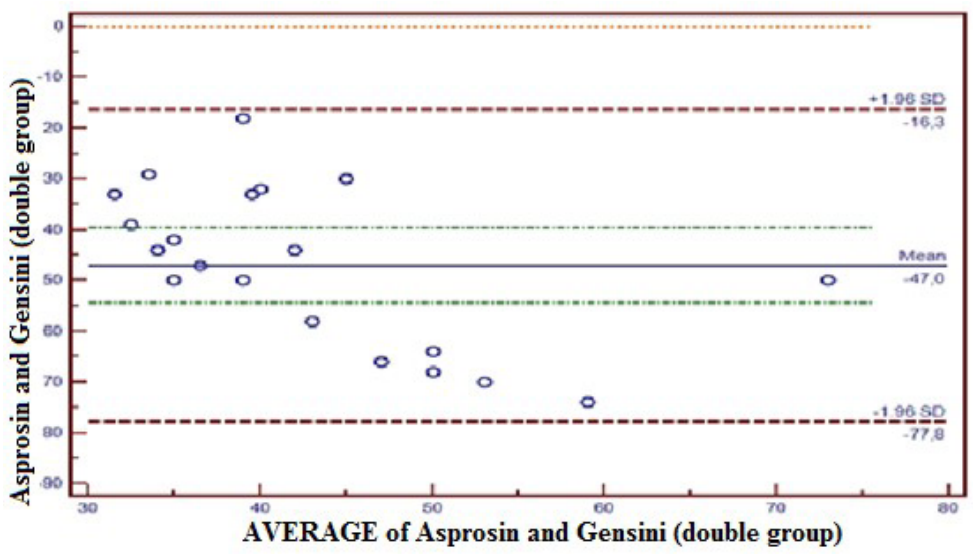
Fig. 4 - Concordance between Asprosin value and Gensini score in the double coronary lesion group. The concordance between Asprosin and Gensini by Bland-Altman method in the double coronary lesion group was -77.8 to 16.3 at a confidence level of 95%. Zero percent (0%) of total observations was observed out of confidence level of 95%. SD=standard